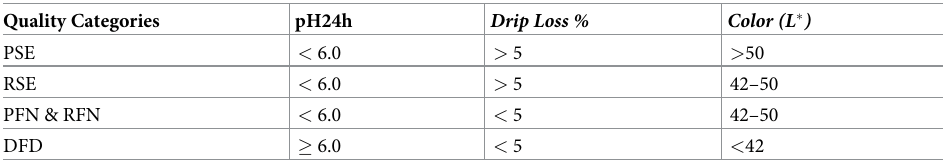
Table 1. Classification of pork quality utilized in this